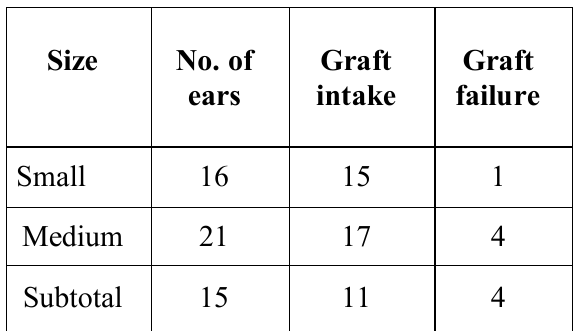
Table 3: Relative frequency of graft takes rate in relation to the size of perforation